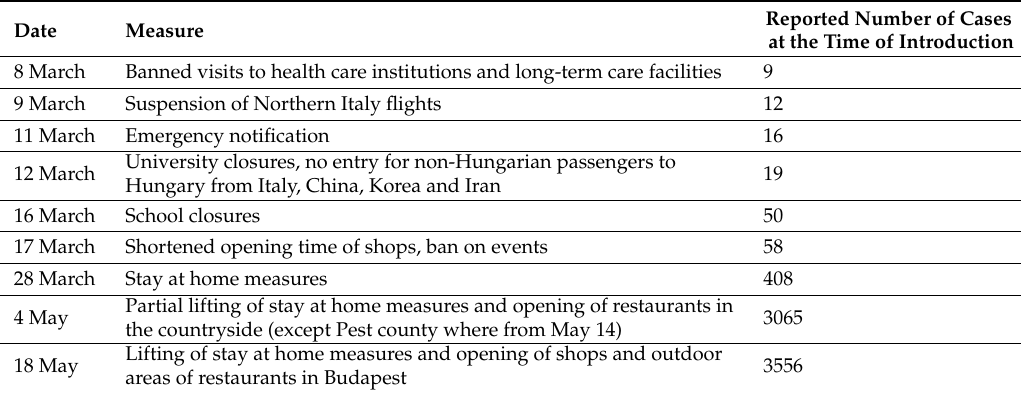
Table 9. Measures applied in Hungary with the date of